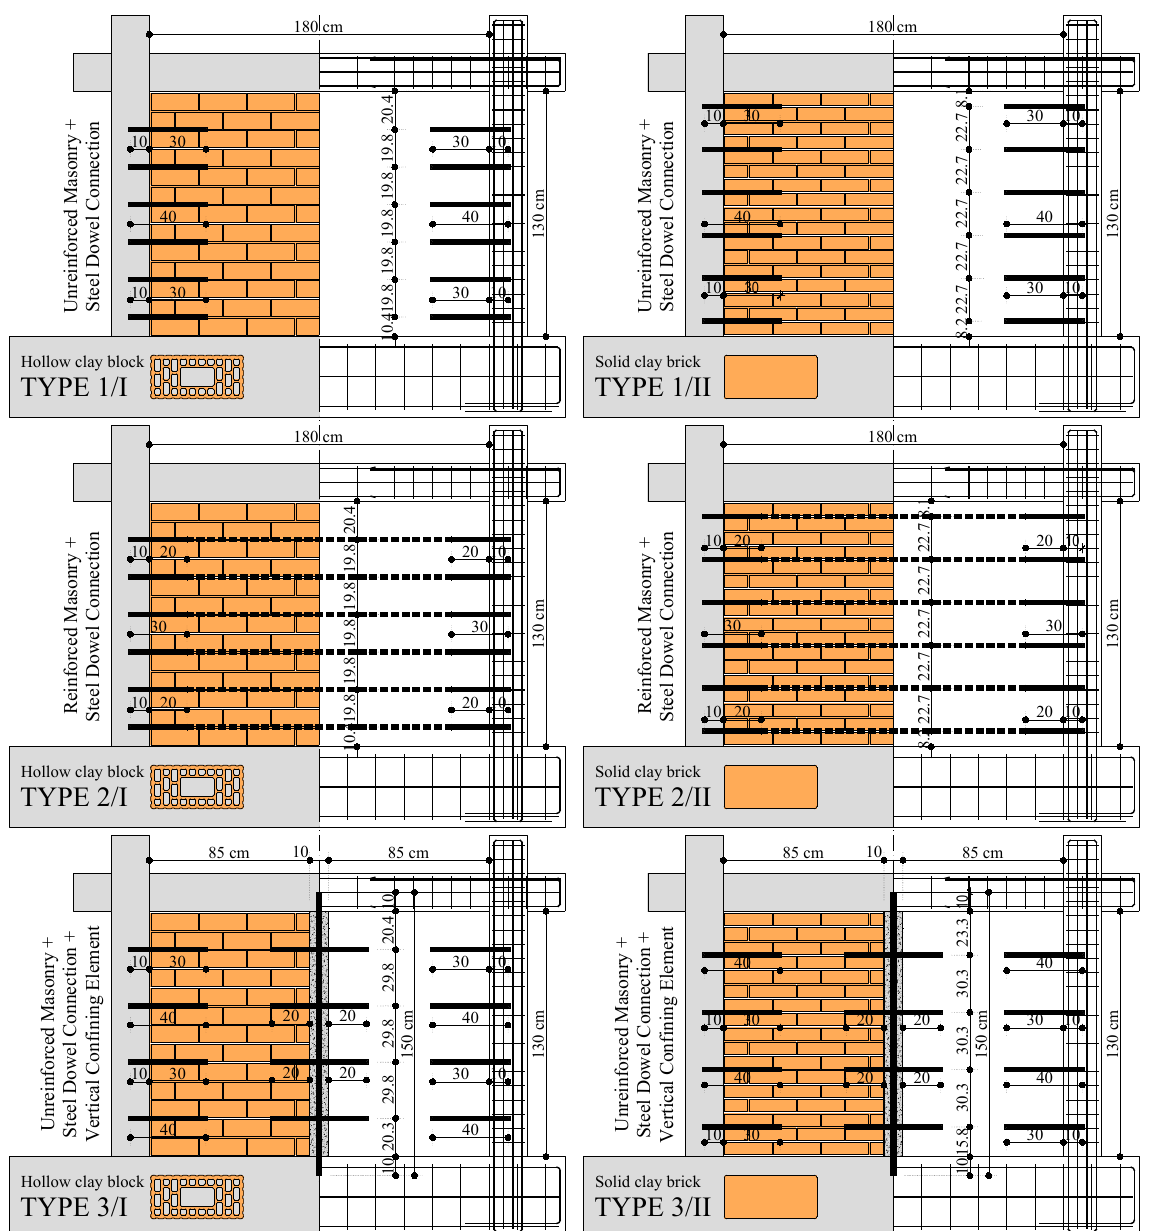
Figure 2. The applied methods of the masonry infill walls. Strengthening methods are shown with and without reinforcement details, i.e., the specimens do not contain any